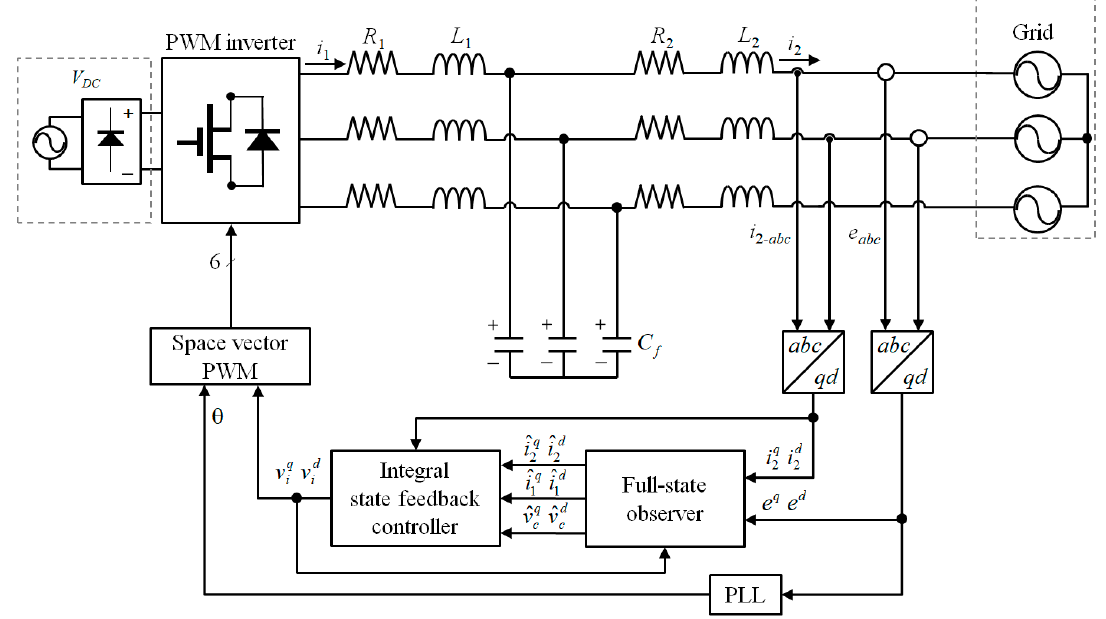
Figure 2. Proposed discrete-time integral state feedback control scheme with state observer for LCL-filtered three-phase grid-connected inverter. PLL: phase lock loop;